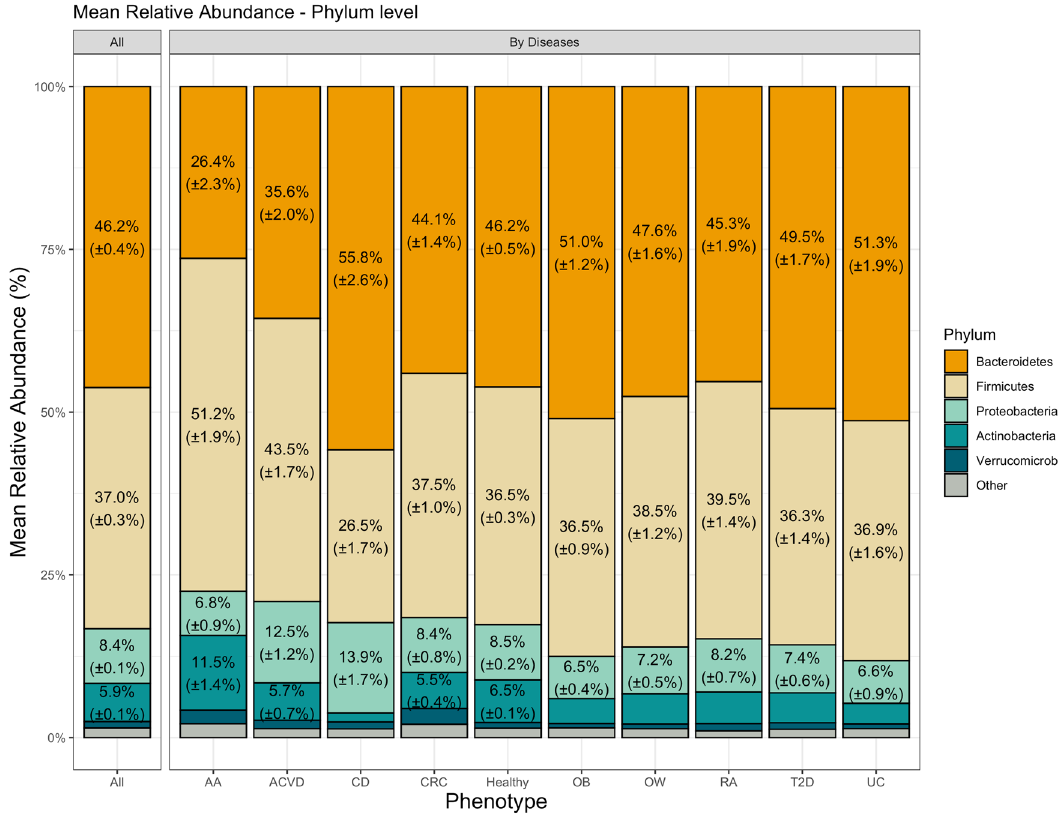
Figure 3. Mean distribution of species found within metagenome datasets by phenotype, agglomerated at the Phylum level. Numbers within each bar represent the mean relative abundance, accompanied by its standard error; only values above 5% are